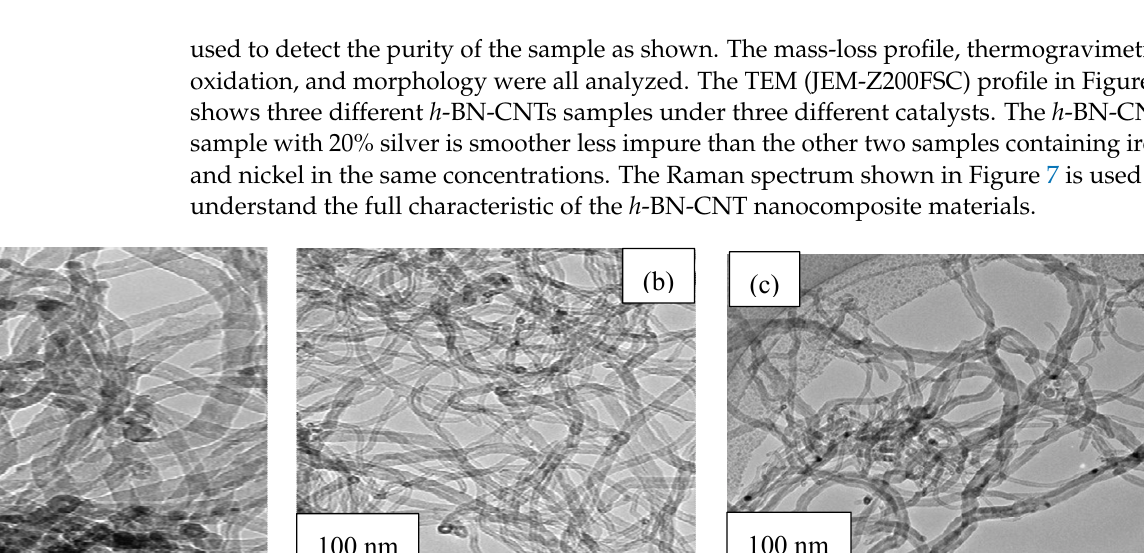
Figure 6. TEM micrographs of h -BN-CNT with ( a ) 20% silver ( b ) 20% iron and ( c ) 20% nickel before thermal treatment. In each case, the as-grown h -CNT was found to be between 10 to 30 nm in diameter as indicated by the TEM analysis and tens of microns in length across all samples. The scraggy nature of the nanotubes can be seen due to the presence of h -BN around the SWCNT. The sample was not purified during the synthesis process because the TGA profile had been used to detect the purity of the sample as shown. The mass-loss profile, thermogravimetric oxidation, and morphology were all analyzed. The TEM (JEM- Z200FSC) profile in Figure 6 shows three different h -BN-CNTs samples under three different catalysts. The h -BN-CNT sample with 20% silver is smoother less impure than the other two samples containing iron and nickel in the same concentrations. The Raman spectrum shown in Figure 7 is used to understand the full characteristic of the h -BN-CNT nanocomposite materials.